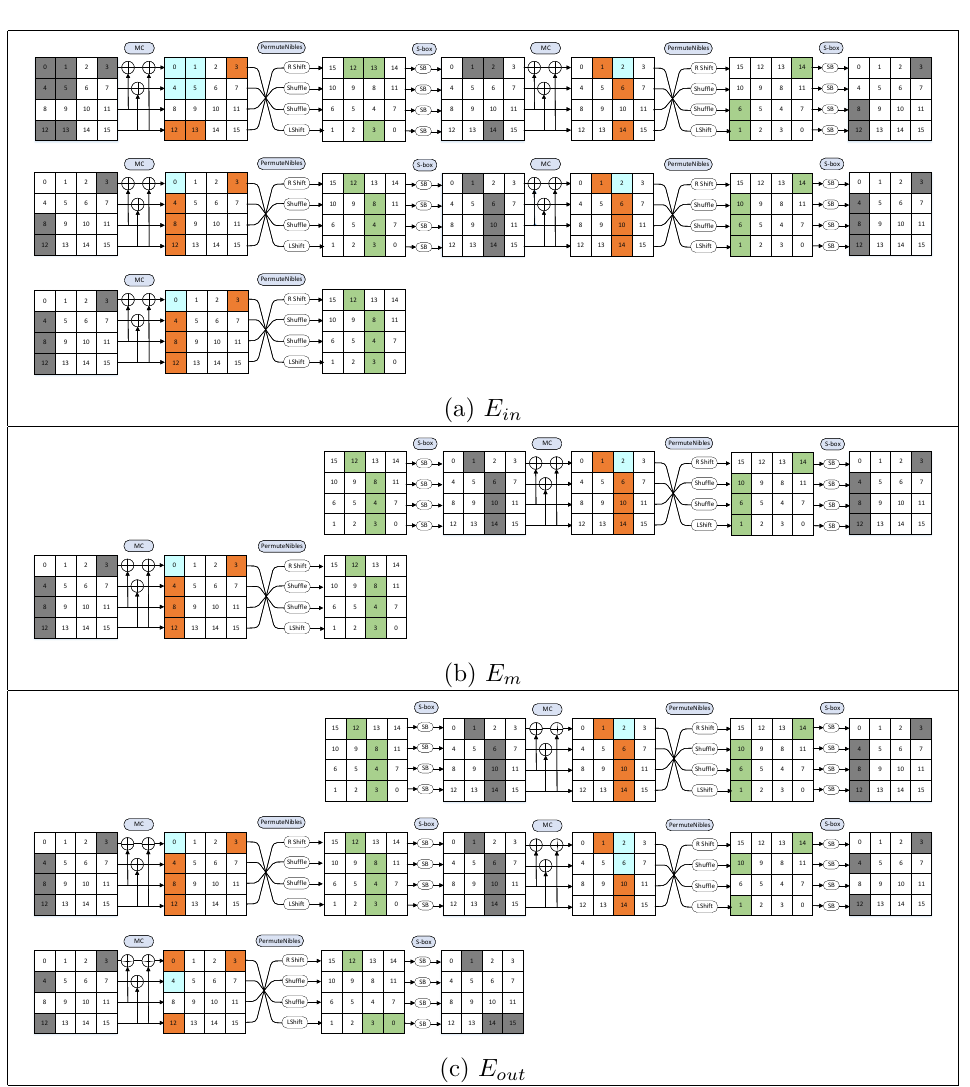
Figure 5: An expendable truncated trail for odd rounds, where E in and E out denote the first 4 and the last 5 rounds, respectively and E m is a repeatable 2-round truncated trail that can be used as much as required. For example, to design a 9-round trail, this stage is